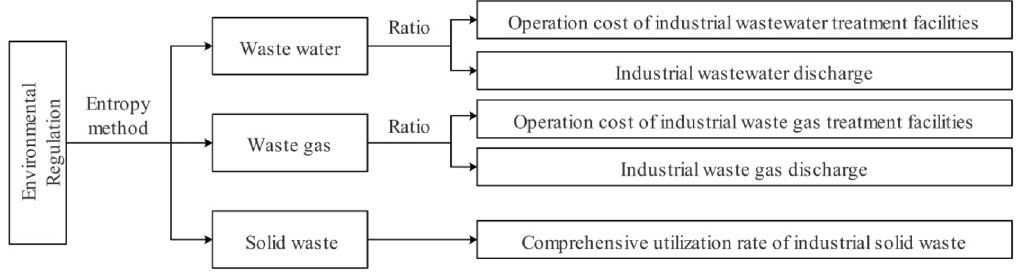
Figure 4. Measurement of environmental